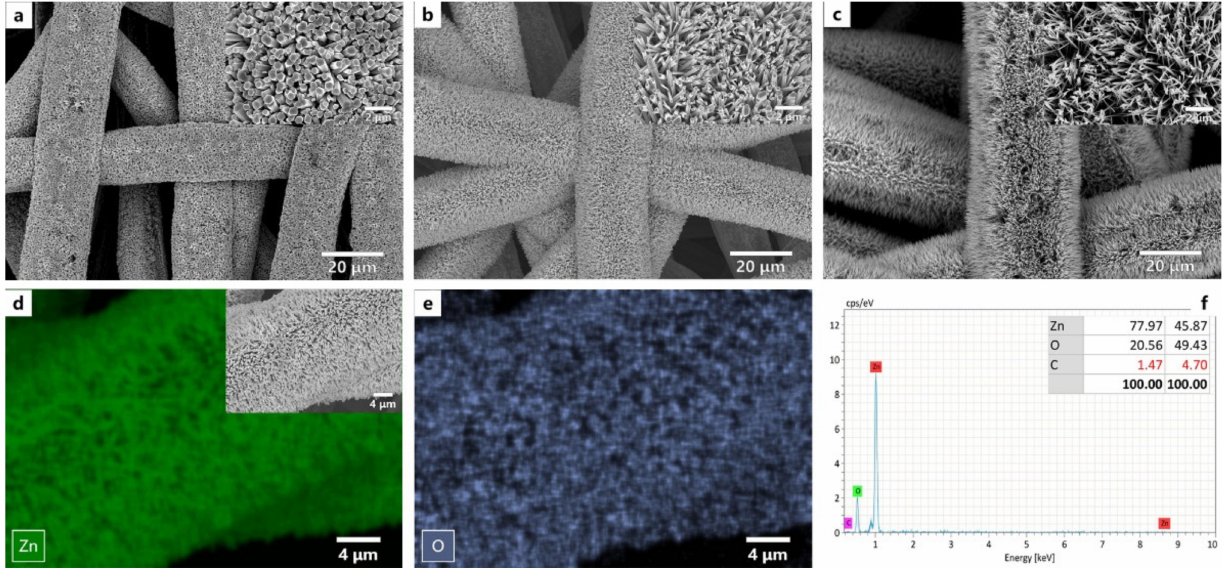
Figure 4. SEM imaging of ZnO-coated filter membranes manufactured with various growth solution concentrations: ( a ) 0.025 mol/L (MF-0.025); ( b ) 0.05 mol/L (MF-0.05); ( c ) 0.1 mol/L (MF-0.1) (The length of the white scalebar in ( a – c ) is 20 µ m, and the size of scalebar in the zoomed picture is 2 µ m); ( d , e ) the original EDS mapping of Zn and O elements in a ZnO coated filter membrane; ( f ) EDS elemental